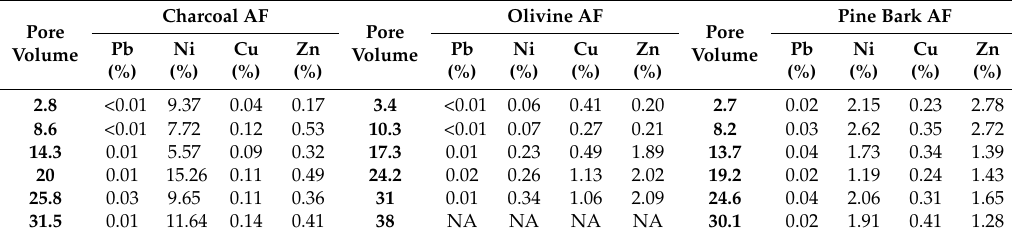
Table 5. Percentage desorption of four metals as a function of pore volume from three alternative filters. Note that the pore volumes are different in each case. NA stands for not available and AF for amended